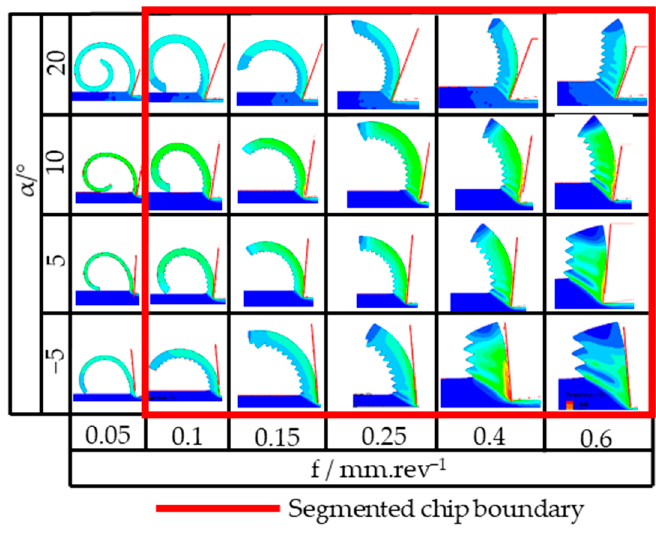
Figure 11. Continuous chip to segmented chip transition prediction by the fracture initiation strain obtained Shear compression specimen. Note: Image magnification not to scale. Note: Image magnification not to scale.